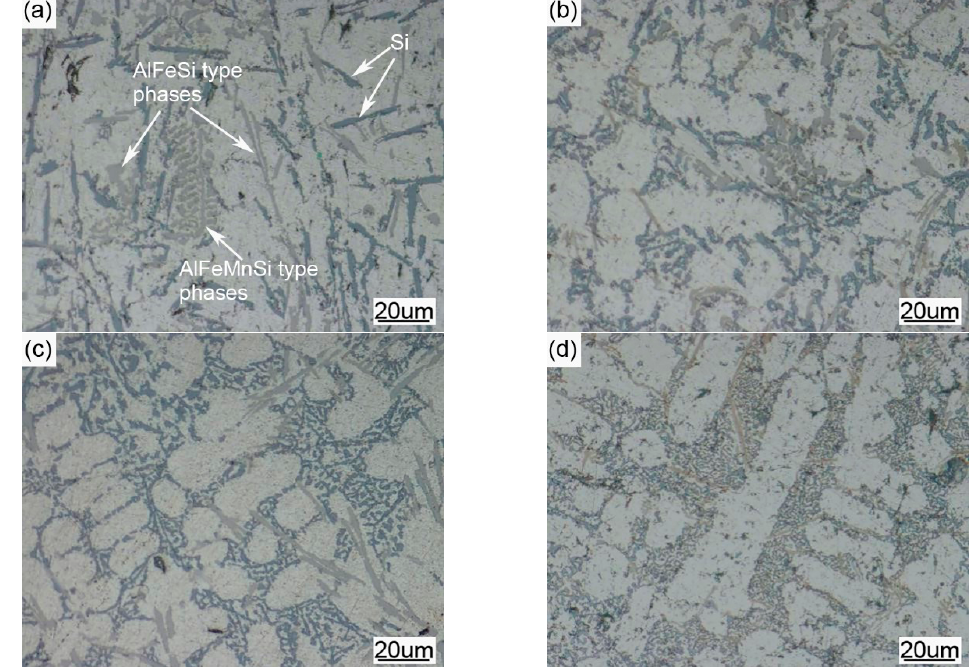
Figure 2. Microstructures of AlSi5Cu1Mg alloy samples with different contents of La: ( a ) 0 wt %, ( b ) 0.3 wt %, ( c ) 0.6 wt % and ( d ) 0.9 wt %.